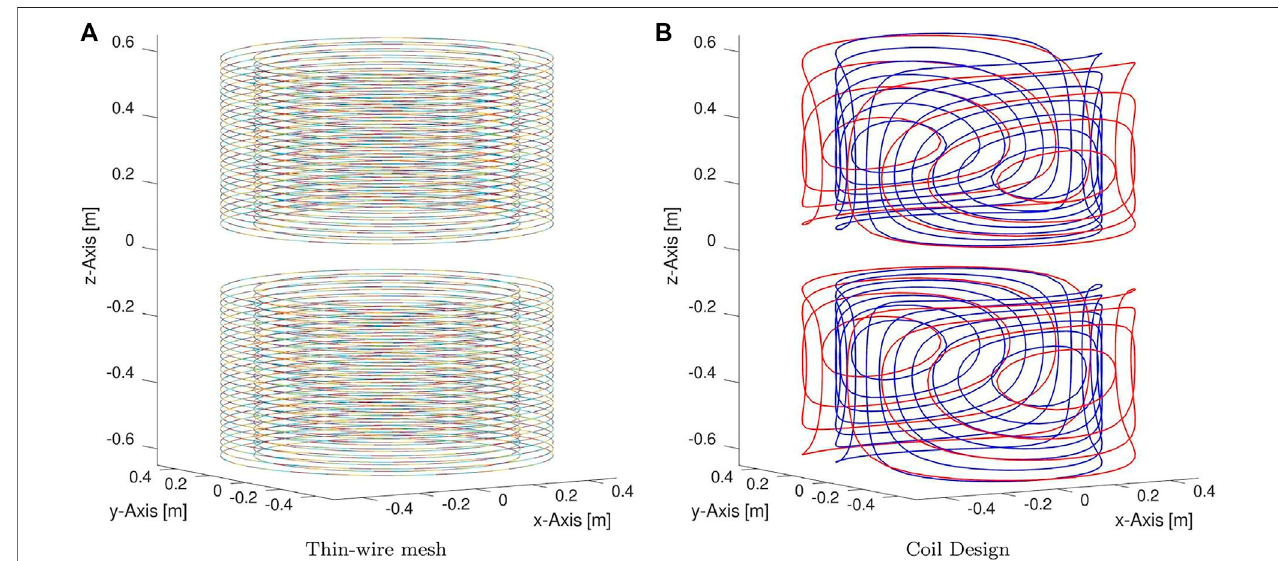
FIGURE 6| A shielded splitcoil design with four independent current carrying surfaces. Depicted are (A) the thin-wire mesh and (B) the resulting wire layout. Such designs are usually deployed in systems which combine linear accelerators for cancer treatment with MRI for